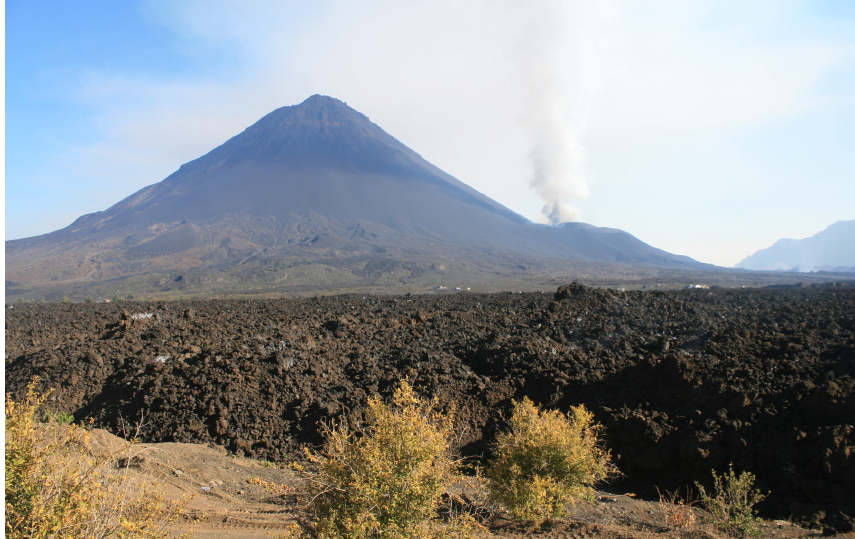
Figure 2. The Chã das Caldeiras and Pico do Fogo during the 2014/15 eruption. View towards the southeast with the ‘a‘ ¯ a lava flows of 2014/15 in the foreground, evidencing a very irregular and inaccessible surface. The active volcanic vent is visible on the SW flank of the Pico do